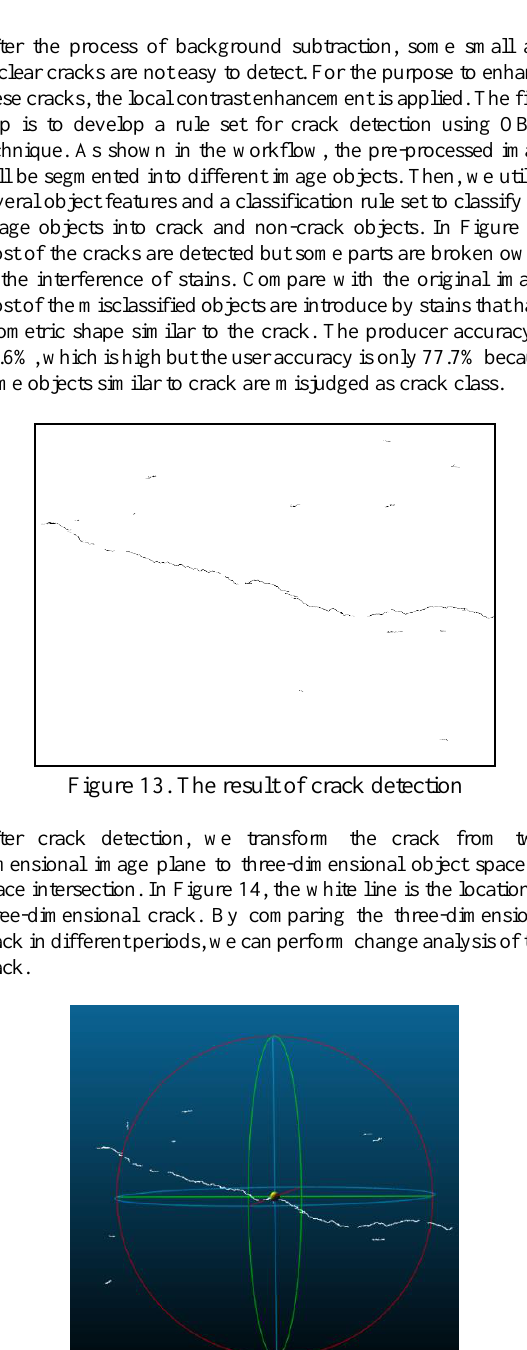
Figure 14. The three-dimensional